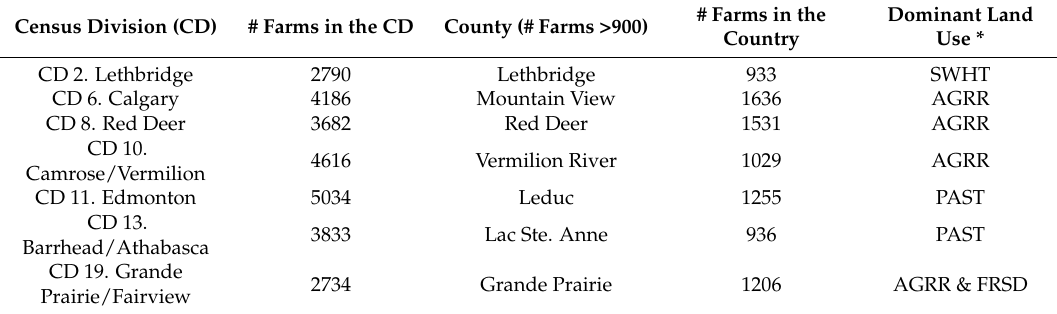
Table 1. Number of farms in seven counties, identified by their census divisions, and selected as case study-2011 Census of Agriculture.